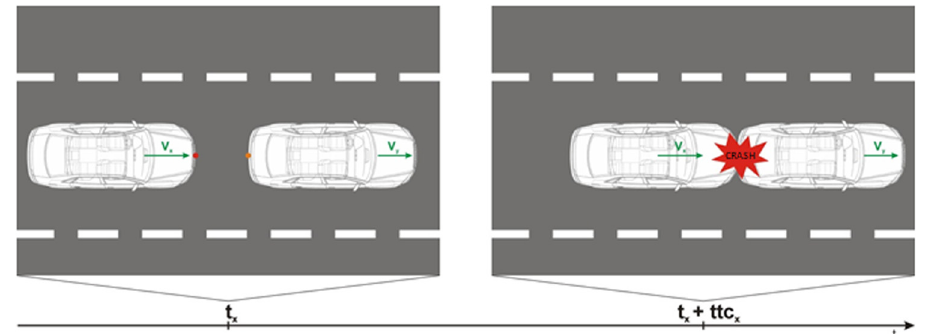
Figure 4: De fi nition of TTC [ 12 ] .